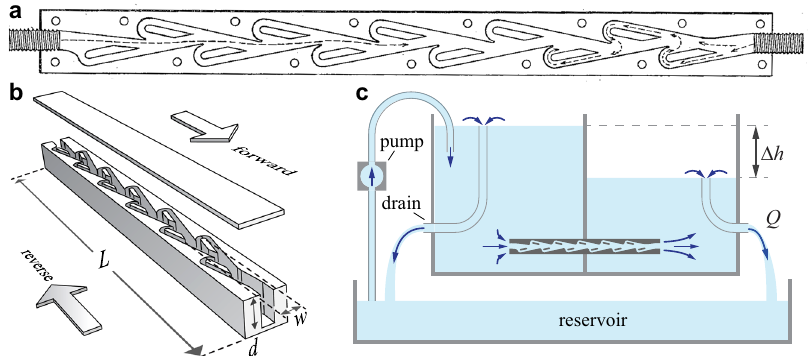
Fig. 1 Experimental tests of Tesla ’ s conduit under steady pressures. a Schematic modi fi ed from Tesla ’ s patent 10 showing a planform view of the `valvular conduit ’ . b Rendering of the conduit used in experiments. Upper and lower lids sandwich the internal geometry, which is digitized from Tesla ’ s design, laser- cut, and bonded. Relevant dimensions include total length L , average wetted width w , and depth d . c Schematic of the pressure chamber. Over fl ow mechanisms ensure fi xed water levels that drive fl ow through the conduit, whose actual orientation is upright as shown in b . The height differential Δ h is varied and volumetric fl ow rate Q measured for both forward and reverse